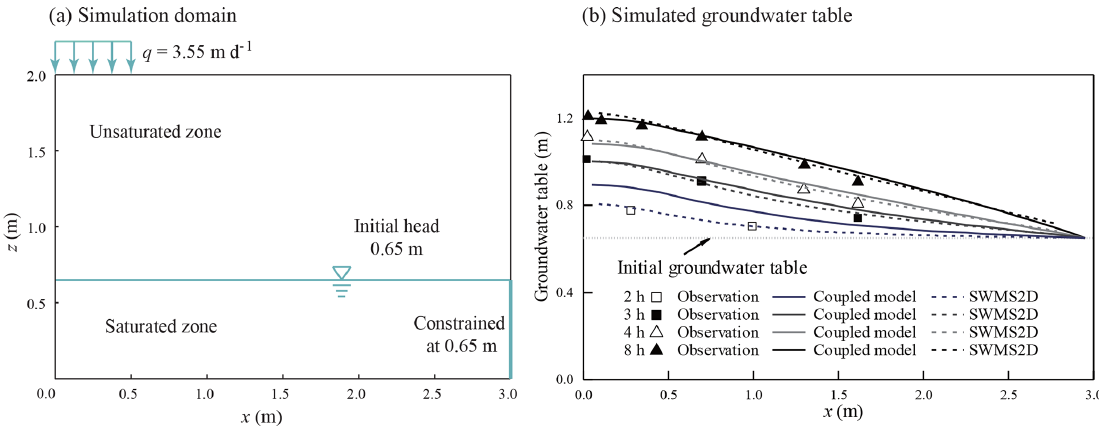
Figure 4. (a) The sketch of the 2-D recharge experiment of case 2. (b) The comparison of the water table between simulated results by the coupled model, SWMS2D, and observation data of case